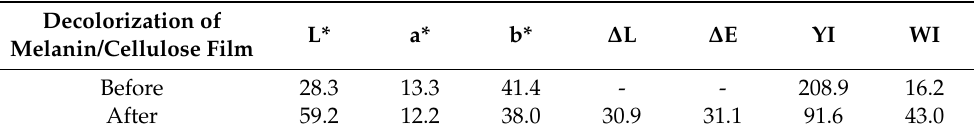
Table 2. Color parameters and indices of the melanin/cellulose hydrogel films before and after the decolorization reaction.